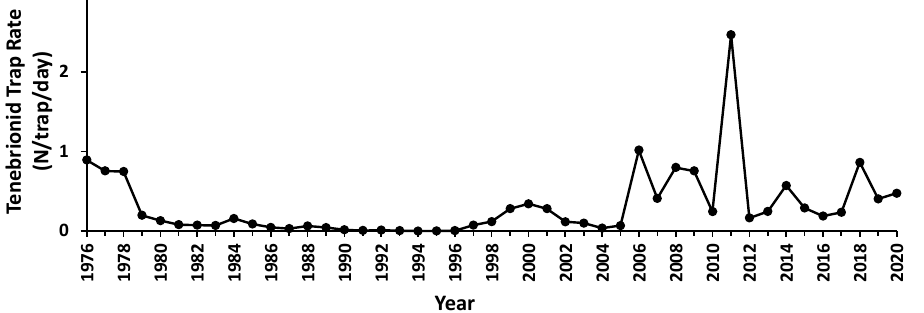
Figure 3. Time series of the annual trapping rate of tenebrionids (N trap − 1 day − 1 ) at the gravel plain study site.